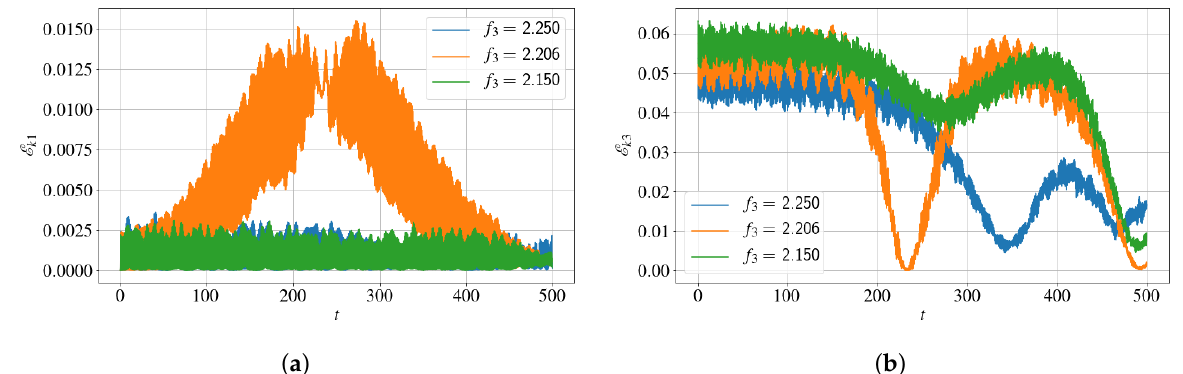
Figure 3. Time series for the efficiency E k (23) (relative amplitude) for the K 1 target mode ( a ) and K 3 ( b ) under plane-wave propagation. A clear increase of energy transfer is observed in K 1 at the resonant frequency ( f 3 / Hz ≈ 2.206, K 3 = 1248 2 π compared to off resonance ( f 3 / Hz = 2.25, K 3 = 1298 2 π